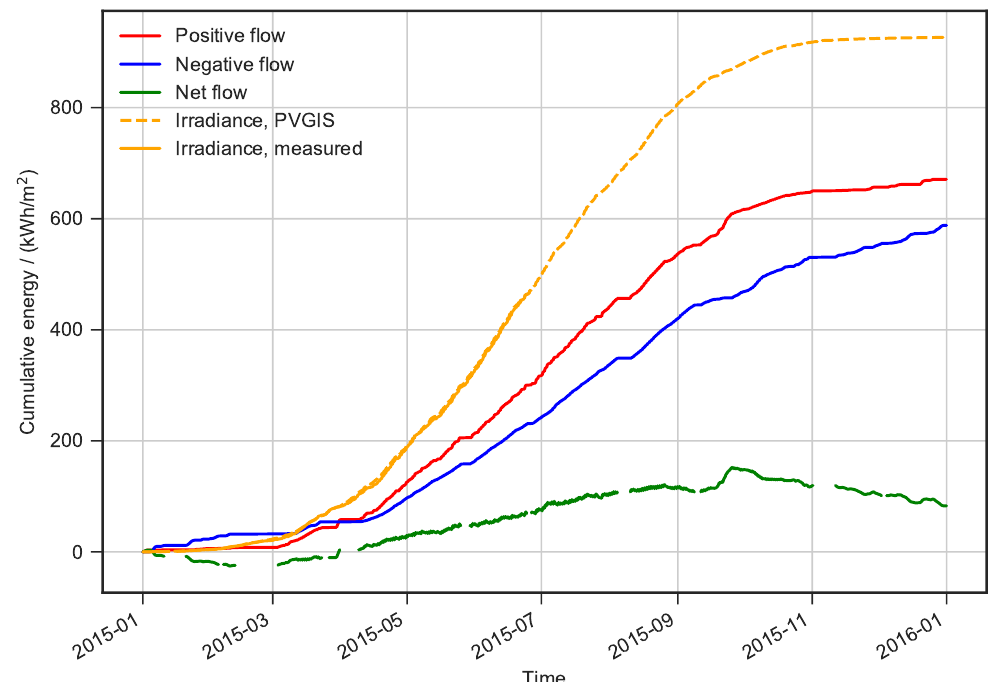
Figure 13. Hourly integrated cumulative irradiance and cumulative heat flux under the asphalt layer over an annual cycle. The net flow consists of the cumulative hourly positive flow into the ground and the cumulative hourly negative flow escaping from the ground. After the warming period, in 26th of September the positive flow is about 70% of the solar irradiance and the net flow is only about 17% of it. Irradiance PVGIS is the Solar irradiance estimated using the Photo Voltaic Geographical Information System